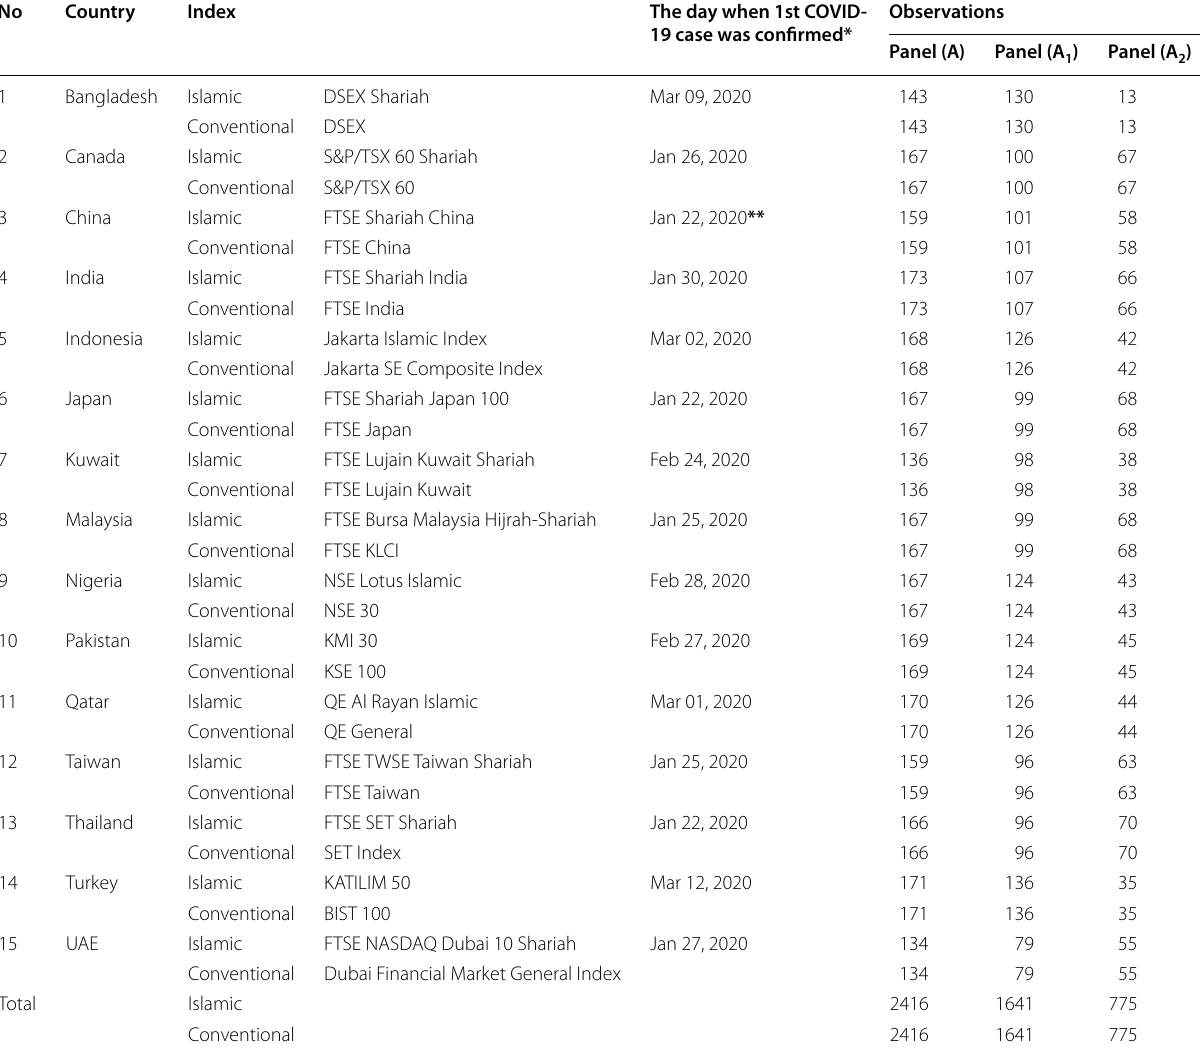
Table 1 List of Islamic and conventional stock market indices from each